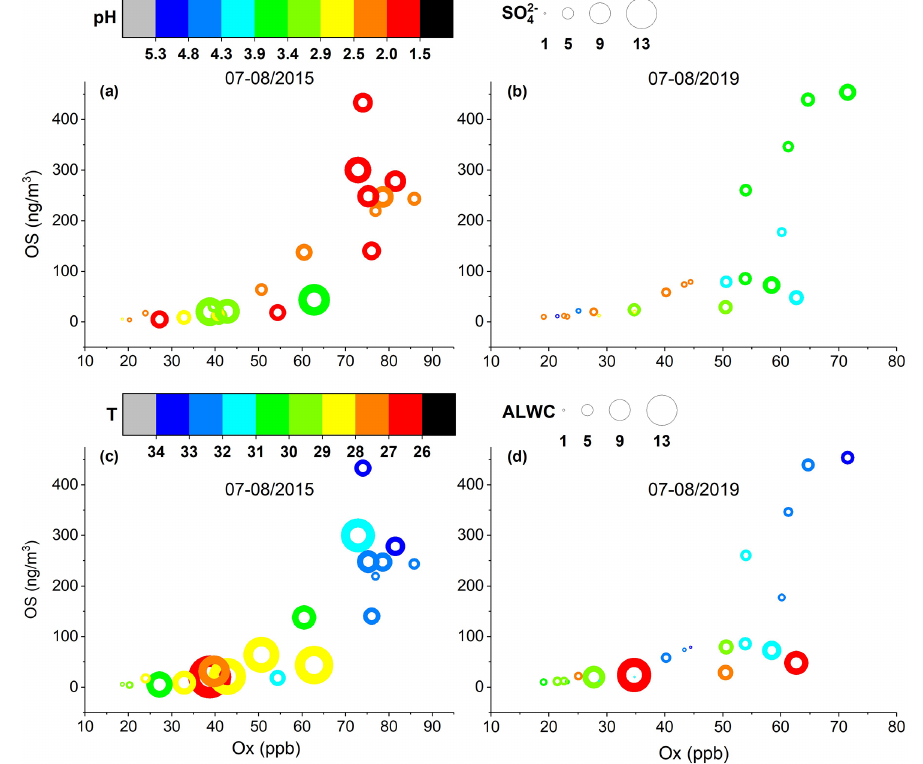
Figure 6. Quantified OS concentrations as a function of the O x level in the summer of (a, c) 2015 and (b, d) 2019. The color of the circles in (a) and (b) indicates the aerosol pH and their size is linearly scaled with the SO 2 − indicates ambient temperature and their size is linearly scaled with the aerosol liquid water content